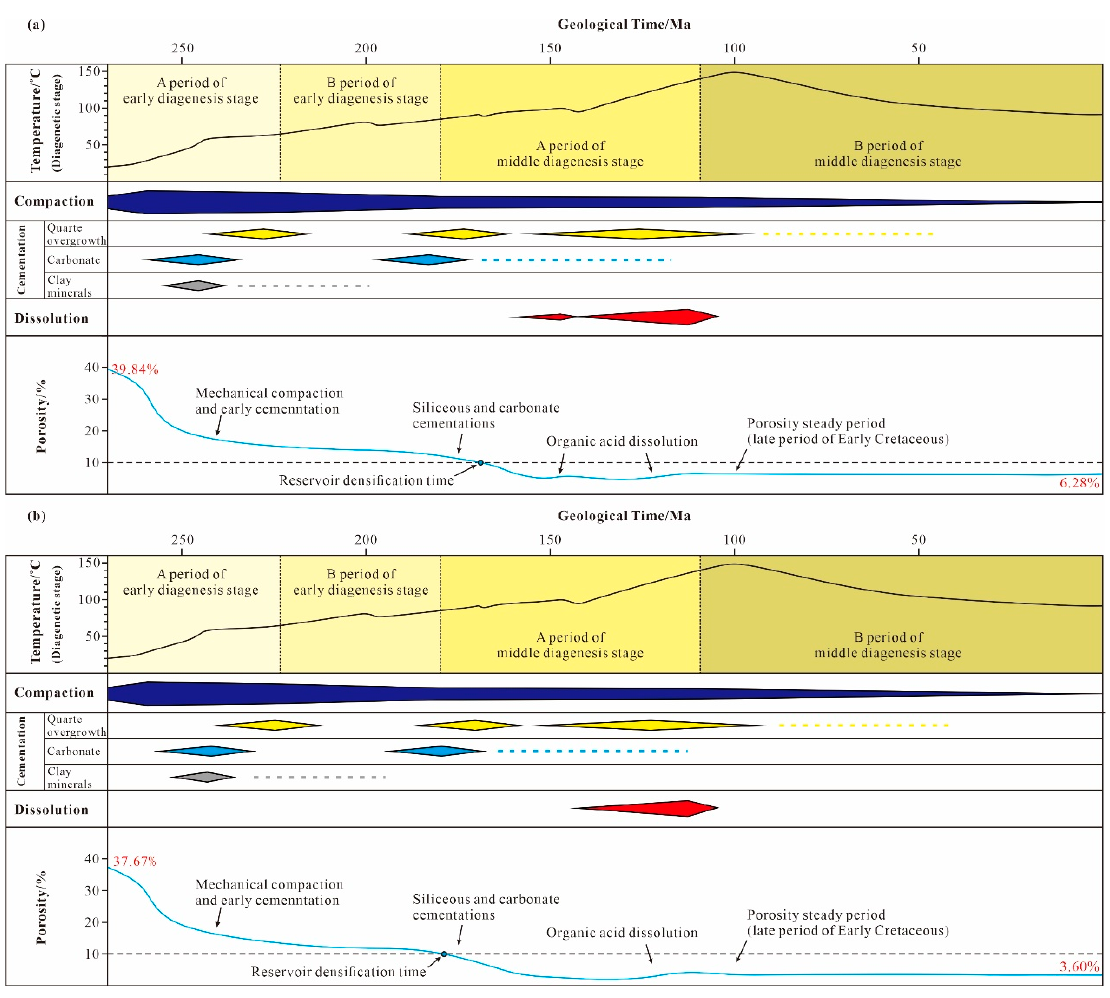
Figure 7. Porosity evolution process of the Lower Shihezi Formation sandstone reservoir of ( a ) well J57 and ( b ) well J110.